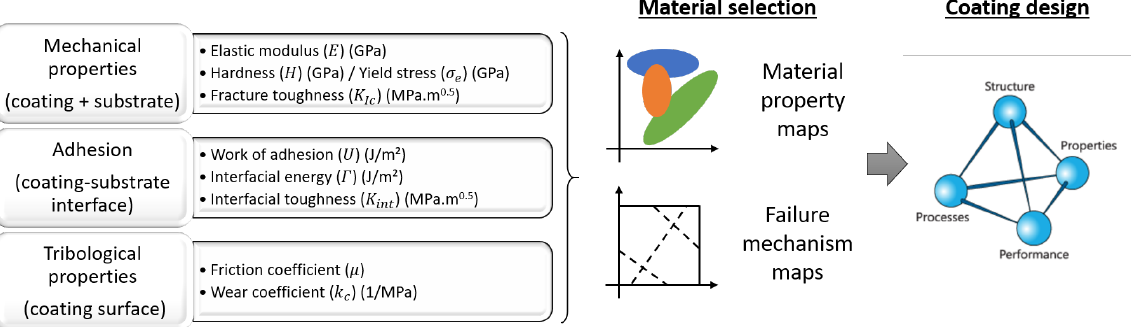
Figure 1. Properties required for selection maps creation to support coating systems